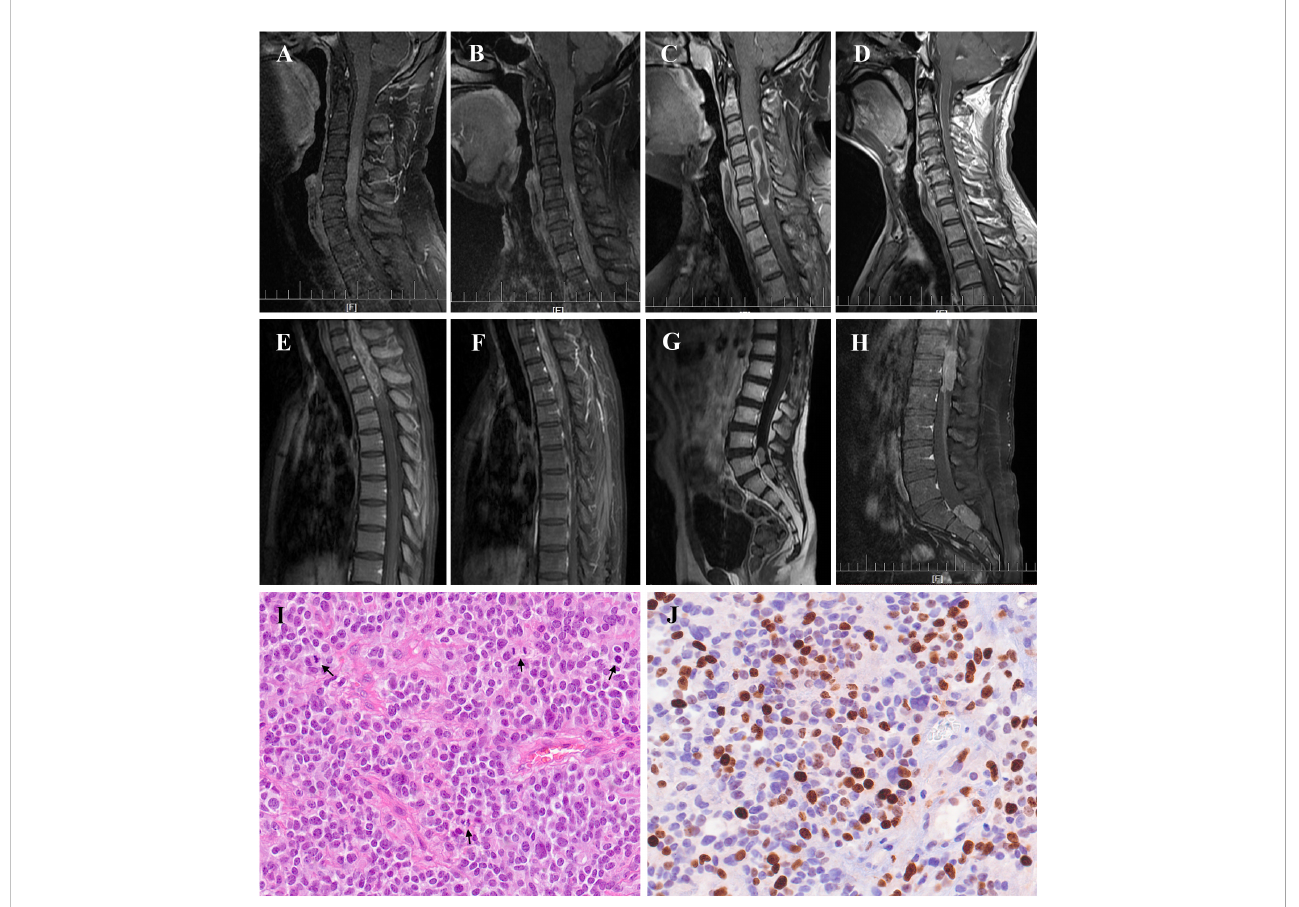
FIGURE 3 Radiological manifestation and histopathology of primary spinal anaplastic ependymomas (PSAE). Magnetic Resonance Imaging of PSAE revealed heterogenous or homogenous contrast-enhancing tumors at various locations within the spinal canal (A – H) . Histopathology of PSAE depicted increased cellularity, brisk mitotic activity, and poor cellular differentiation among typical ependymal tumor features, (I) Hematoxylin and eosin (H&E) 400×; (J) Ki- 67 staining 400×. Black arrows indicated the mitotic phases in (I)